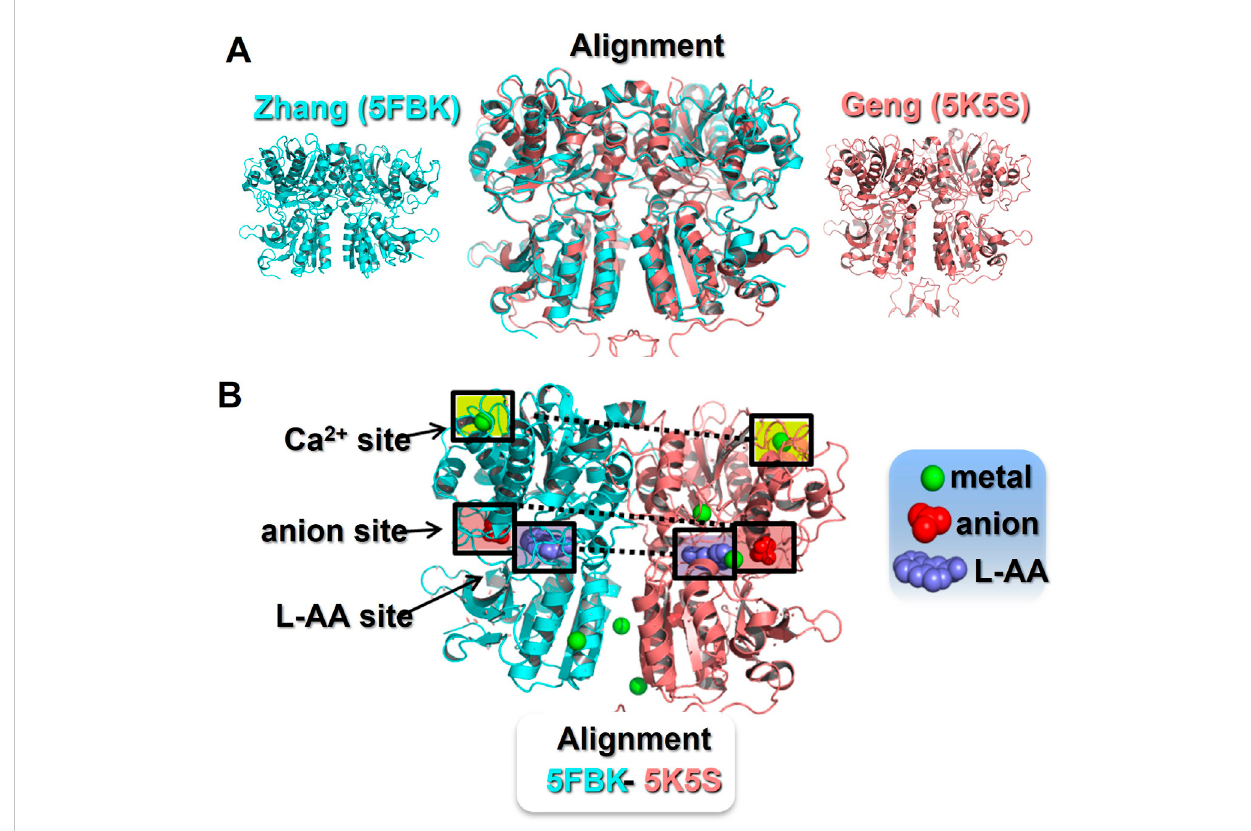
FIGURE 1 Identi fi cation of ionic binding sites in the CaR extracellular domain. Panel (A) Sequence alignment and structural superposition of the currently available CaR ECD models in theactive conformation. TheZhang etal. (2016) model (5FBK) isshown inblue (left)and the Geng etal. (2016) model (5K5S) is shown in pink (right). In the middle, an alignment of both models reveals an almost identical CaR ECD structure with minor differences. Pymol root mean square deviation (RMSD) 0.5, after 5 cycles of iteration. Panel (B) Active conformation of the CaR ECD with reported ligand binding sites. The Zhang model(5FBH) isshownas theleftmonomer,withtheGeng model(5K5S)ontheright. TheZhang model describes threeCa 2+ -bindingsites,onein the upper domain and two in the lower domain facing the interface between monomers. At the same locations, the Geng model describes two Ca 2+ - binding sites, but two additional Ca 2+ -binding sites in the cleft between the upper and lower domains. Both models identi fi ed a common L-amino acid binding site and a common anion binding site, both located at the cleft between the upper and lower domains. In addition, the Geng model includes an anion binding site located in the lower domain. The ligand binding sites highlighted in boxes are those found in both crystal models. L-AA, L-amino